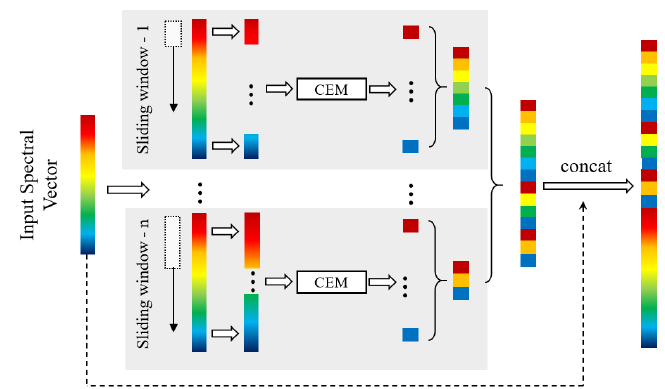
Figure 2. An illustration of the multi-scale scanning stage for spectral feature